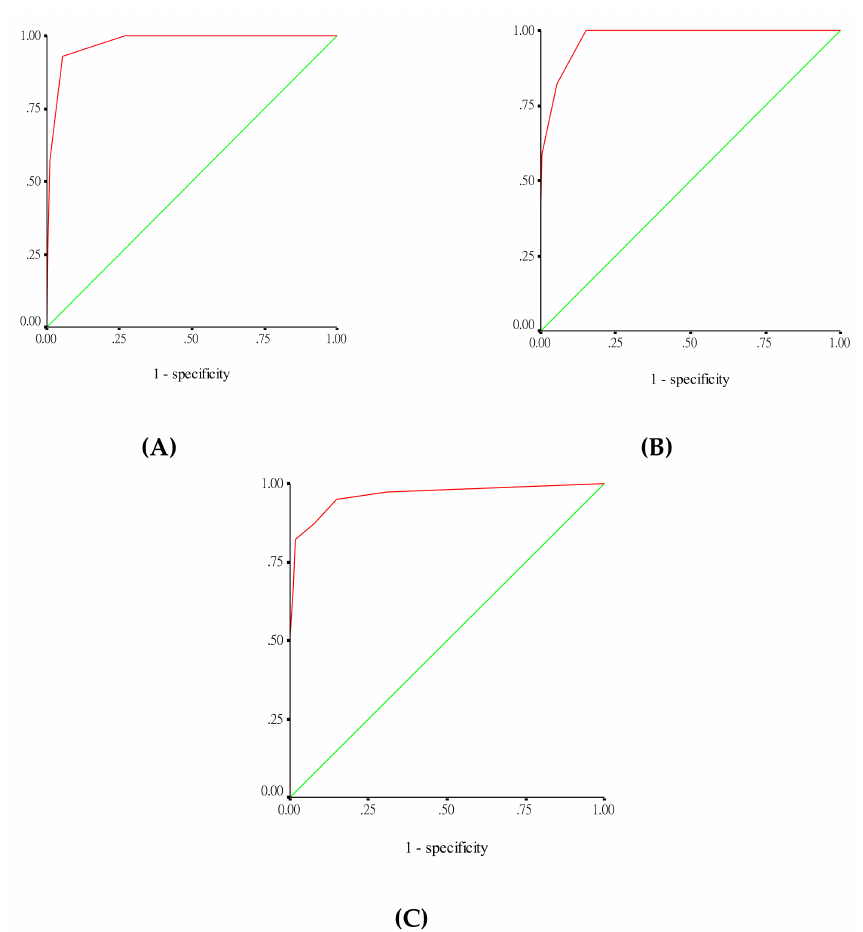
Figure 3. Receiver operating characteristic curve for differentiating survivors from non-survivors: ( A ) survivors versus individuals who died ≤ 3 days after presentation, ( B ) survivors versus individuals who died ≤ 7 days after illness onset, ( C ) survivors versus overall fatal